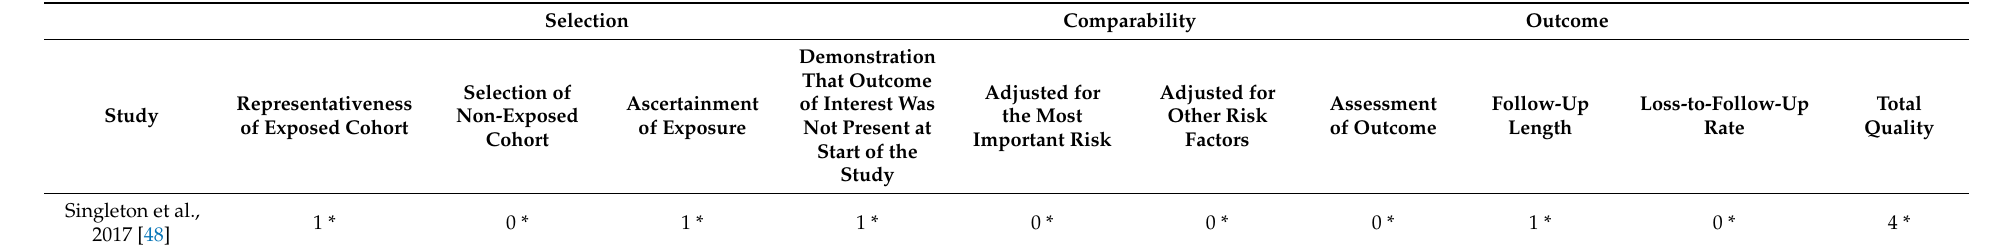
Table 2. Newcastle–Ottawa Scale (NOS) adapted for cohort